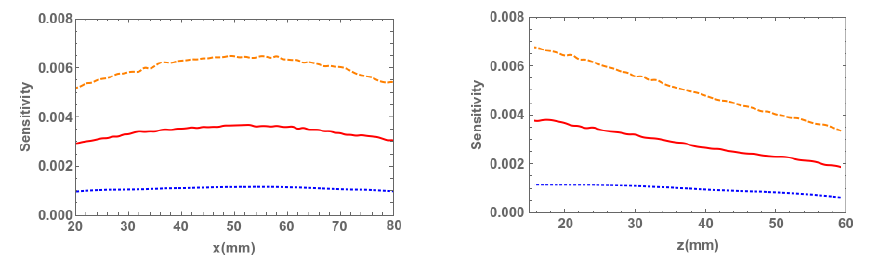
Figure 3. Detector sensitivity (cps/Bq) evaluated along a line parallel to the x axis (see reference system defined in Figure 2) passing through the center of the detector at z = 15 mm, where x = 50 mm represents the coordinate of the center of the detector ( left ), and along the z axis also passing though the center of the detector, where the z coordinates stand for the distance from the source to the collimator ( right ). The blue doted curve represents the linear motion, the red solid curve stands for circular motion without overlapping and orange dashed curve represents circular motion with